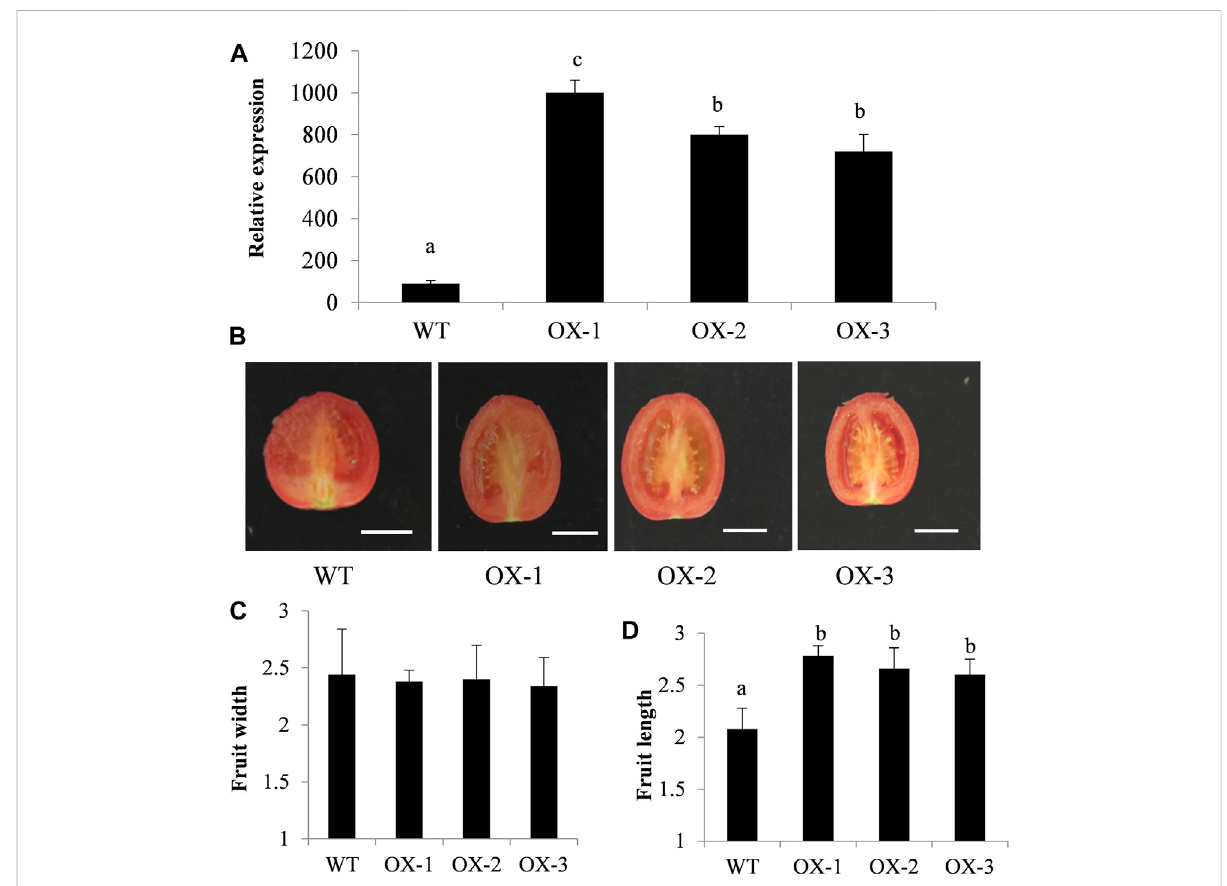
Phenotypic characterization of 35S:ClIQD24 transgenic plants in tomato. (A) The expression level of ClIQD24 in the control and three transgenic lines. (B) Phenotype of ClIQD24 overexpression in Mic-Tom tomato. (C-D) The statistical analysis of fruit width and length (10 individuals were evaluated for each line), the unit of measurement was